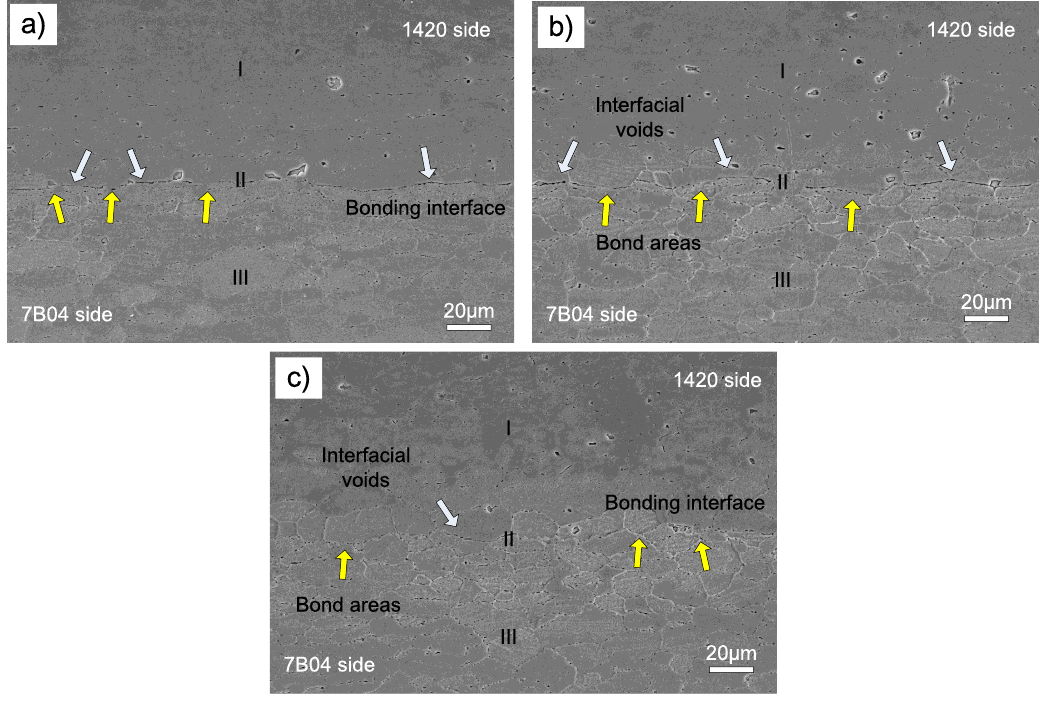
Figure 9. SEM images of the 1420-7B04 interface microstructure after bonded at different temperatures: ( a ) 460°C; ( b ) 490°C; ( c ) 520°C.